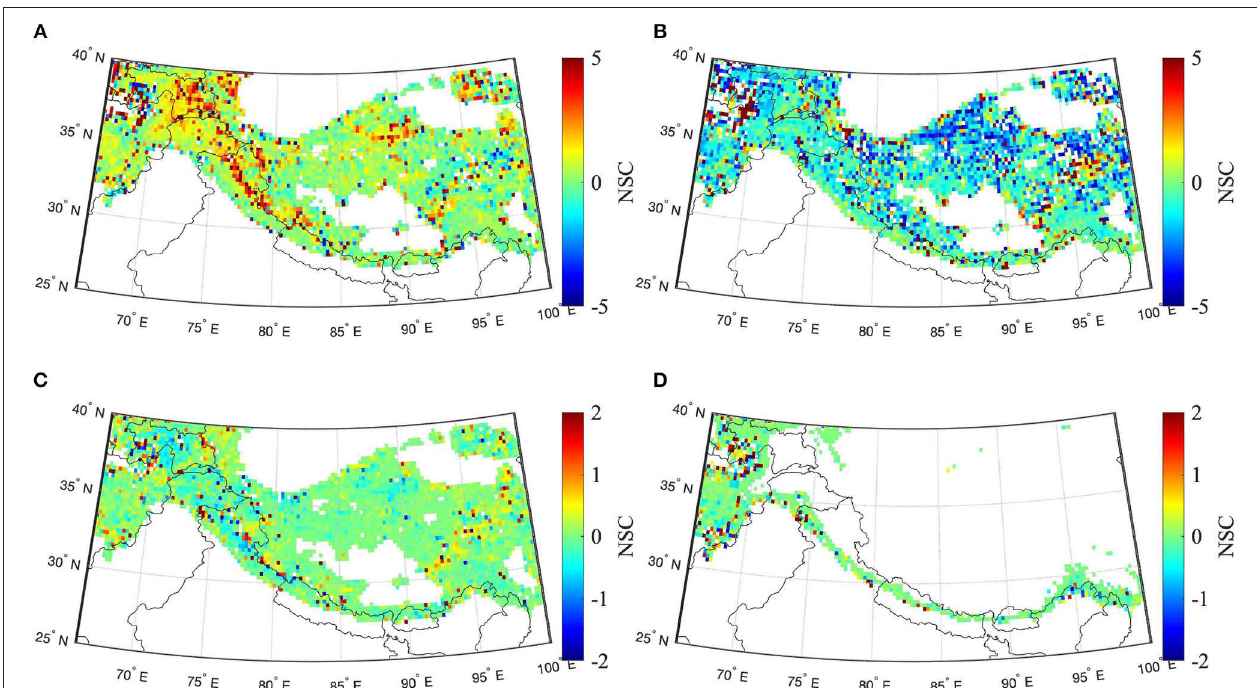
FIGURE 6 | Maps of NSCs from SVM-based predictions of 1 Tb 18.7–36.5 V averaged over the snow accumulation months (Dec, Jan, Feb) from 2002 to 2011 for snow-covered areas in HMA. (A) Snow density [kg/m 3 ], (B) snow temp. (top layer) [K], (C) snow water equivalent [m], and (D) snow liq. water content [mm].